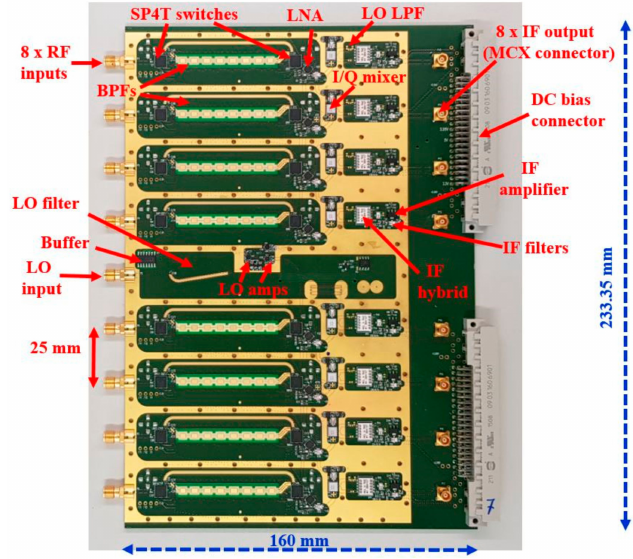
Figure 12. Photo of fabricated PCB assembled with